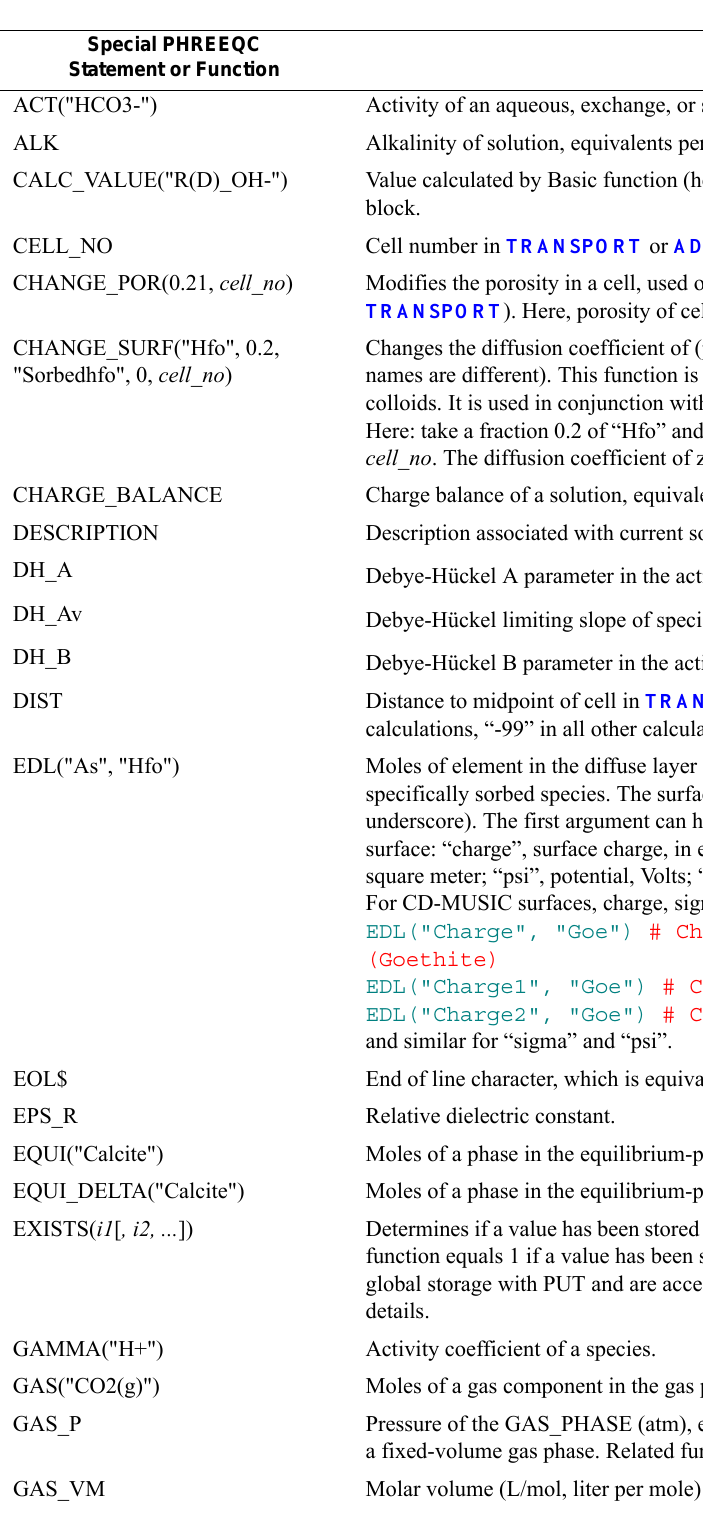
Table 8. Special Basic statements and functions for